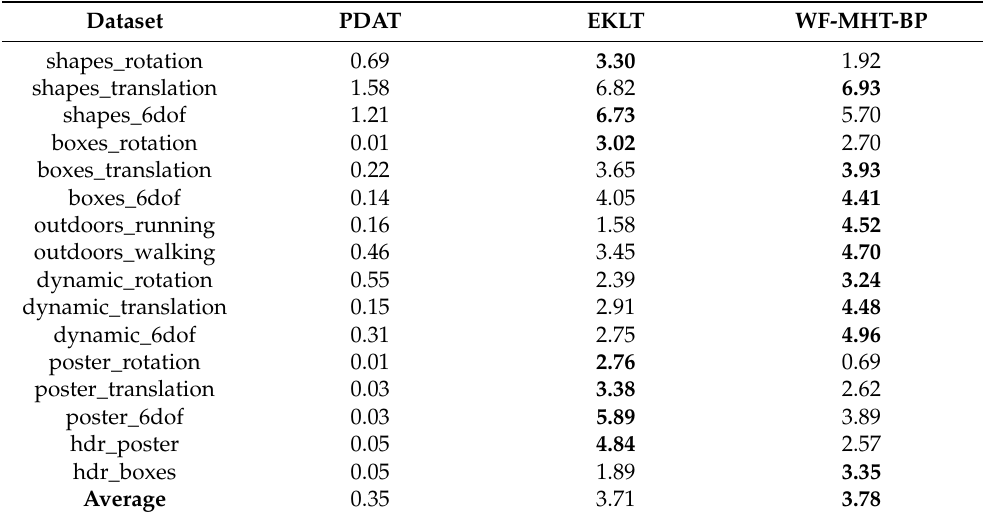
Table 4. Average duration of one track for PDAT/EKLT/WF-MHT-BP methods (unit: